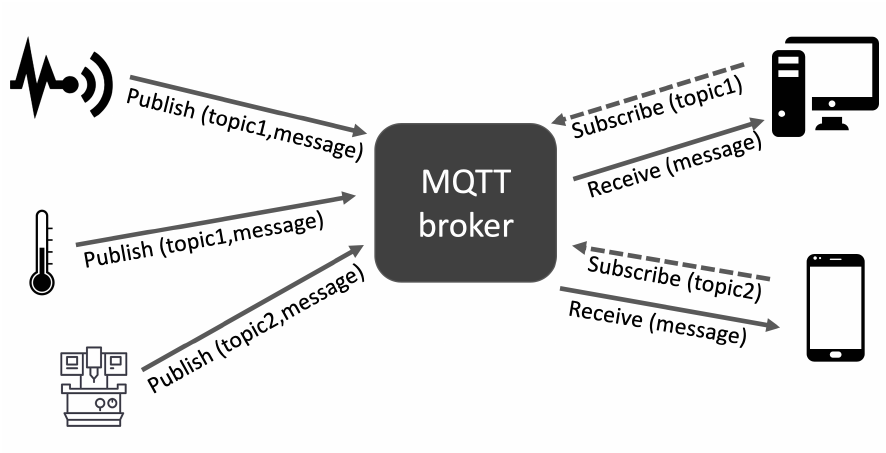
Figure 1. Network sample representation of the Message Queue Telemetry Transport (MQTT) publish/subscribe